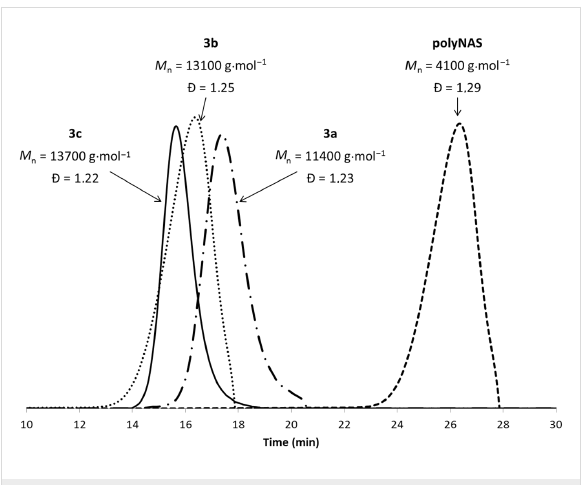
Figure 4: Size-exclusion chromatography of polyNAS and polymers 3a , 3b and 3c